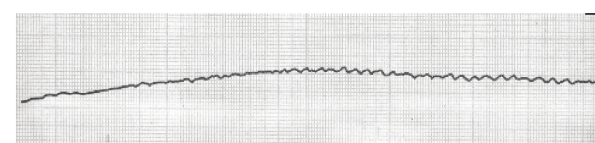
cystostomy catheter